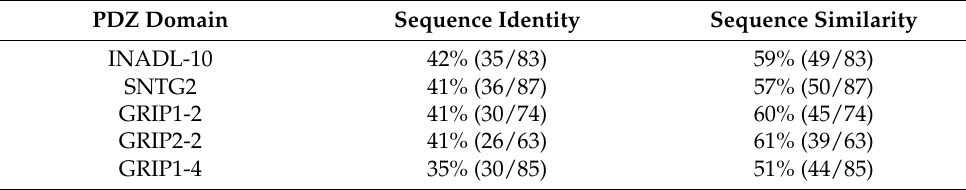
Table 1. Highest sequence identity values of human PDZ domains with A9UPE9 PDZ.